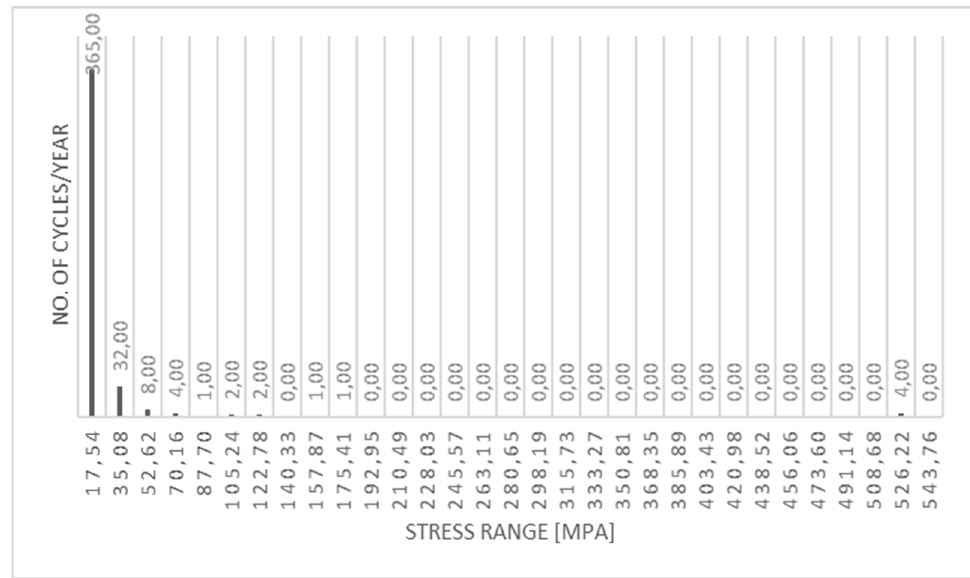
Figure 18. Stress range rainflow chart, point P1v1, [MPa].